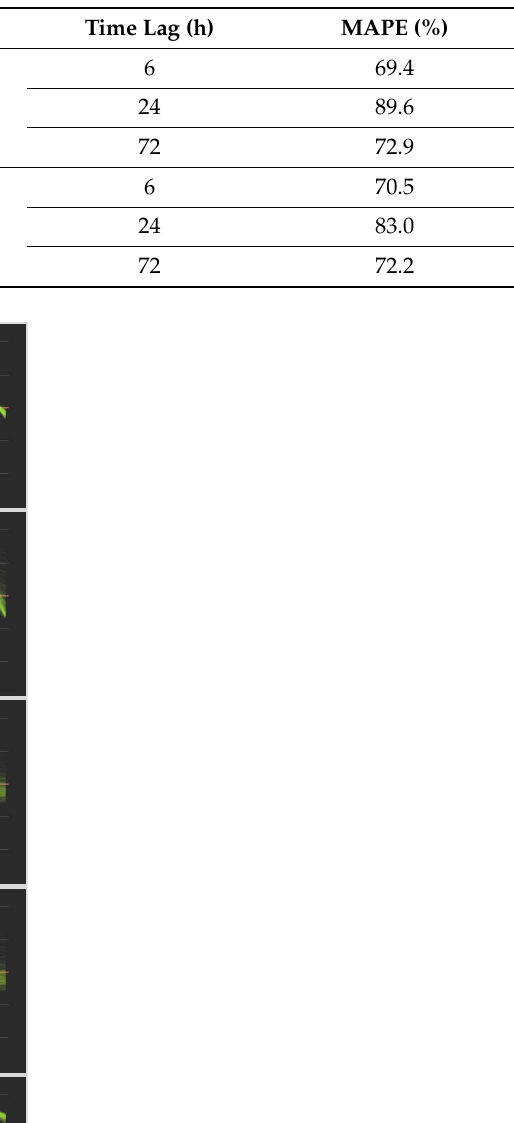
Table 1. Prediction accuracy of different time lags and models with PM 2.5 and PM 10 for gated recur-